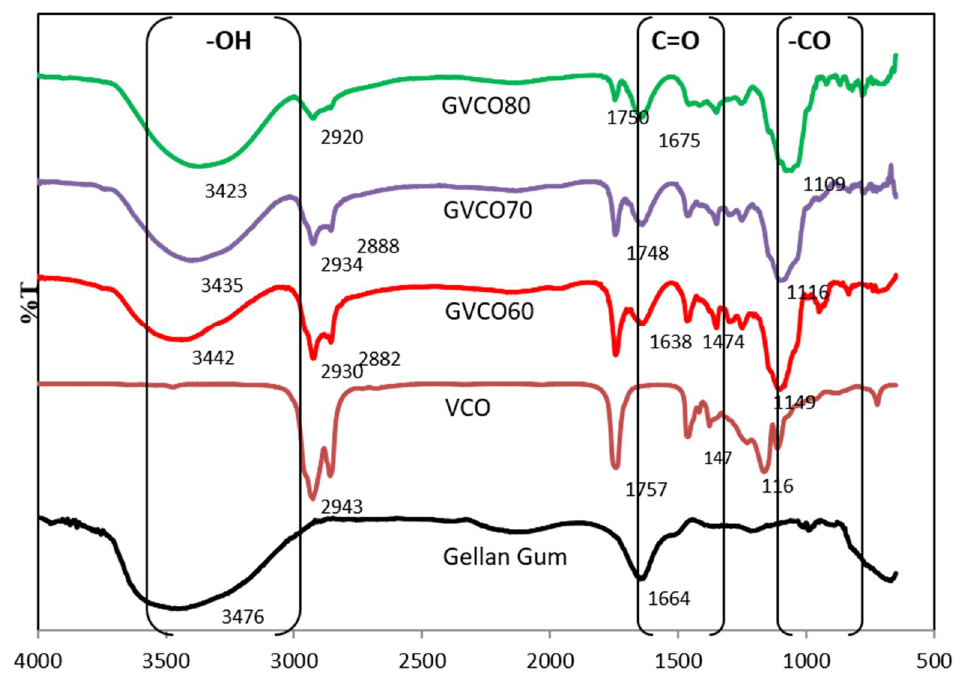
Figure 3. ATR spectra of pure GG hydrogels, VCO, and GVCO hydrogels at different concentrations.